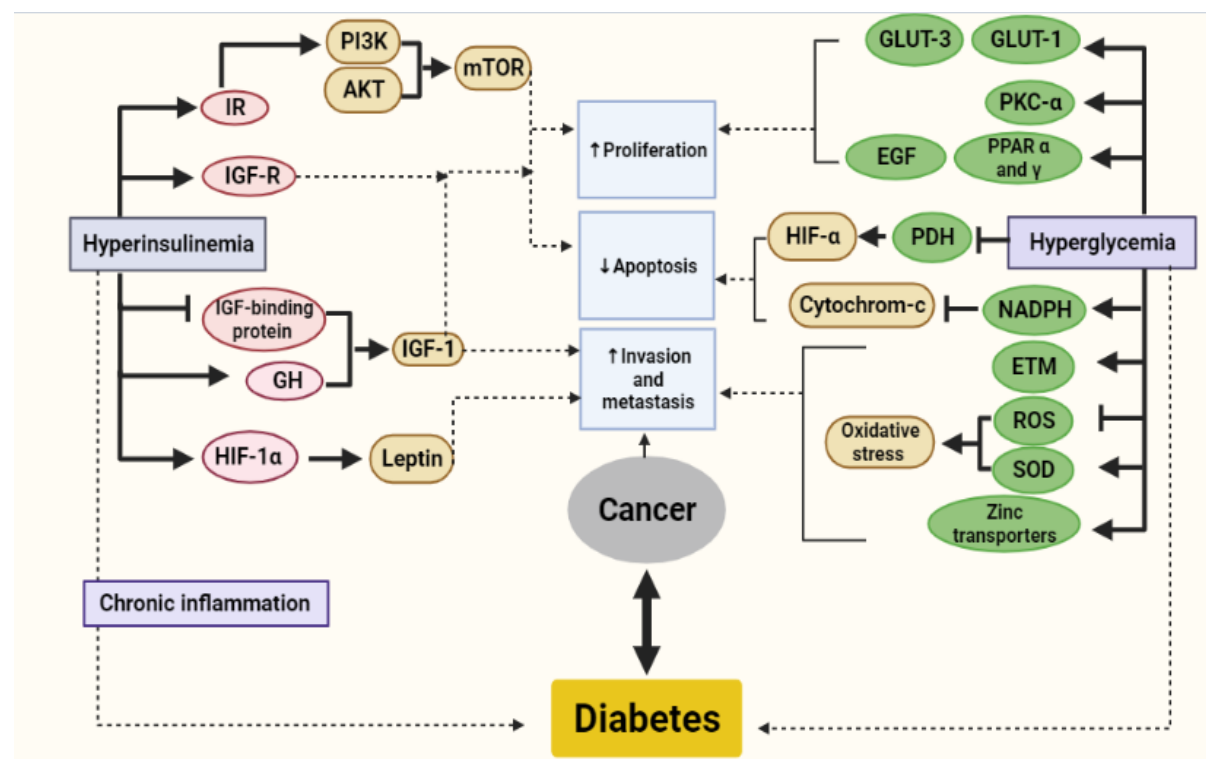
Figure 2. Metabolic link between diabetes and cancer. ( → ), activation; ( ┬ ), inhibition; IR, insulin receptor; IGF-R, insulin-like growth factor receptor; PI3K, phosphoinositide 3-kinase; AKT, protein kinase B; mTOR, rapamycin signaling pathway; GH, growth hormone; IGF-1, insulin-like growth factor 1; HIF- α , hypoxia-inducible factor-1 α ; GLUT, glucose receptor; PKC- α , protein kinase C; PPAR, peroxisome proliferator-activated receptor; EGF, epithelial growth factor; PDH, prolyl hydroxylase; NADPH, nicotinamide adenine dinucleotide phosphate; ETM, epithelial to mesenchymal trasition; ROS, reactive oxygen species; SOD, superoxide dismutase. Created using Biorender software.